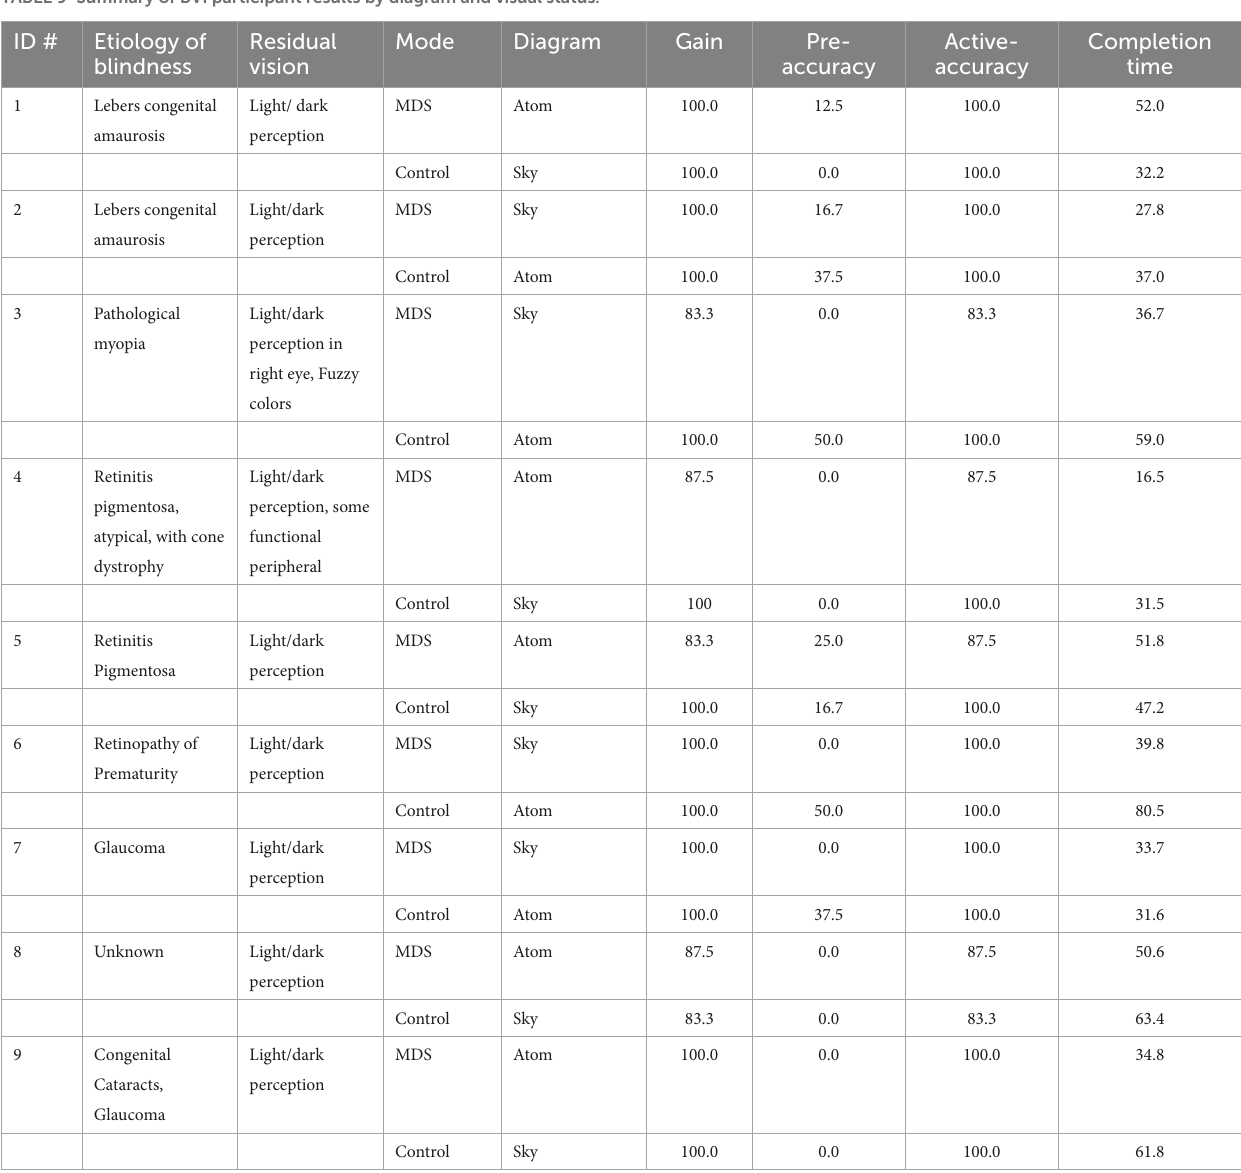
TABLE 9 Summary of BVI participant results by diagram and visual